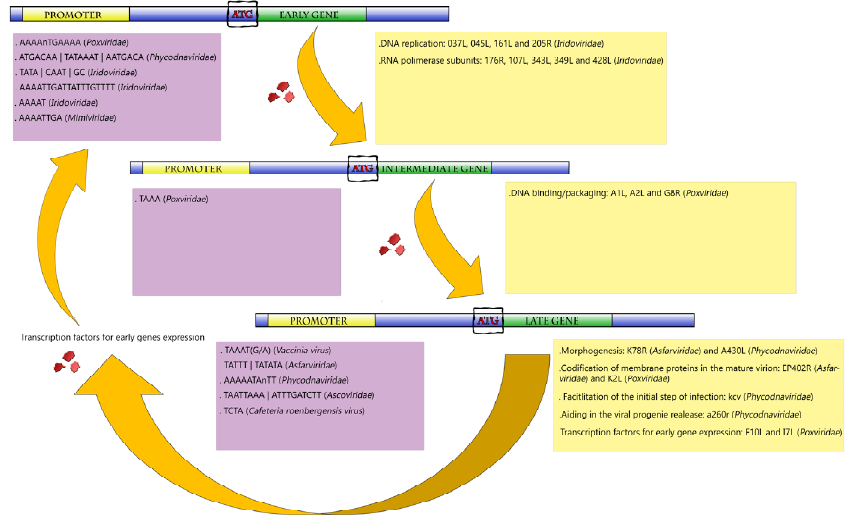
Figure 2. Representative scheme of the temporal gene expression in NCLDVs. During initial times of infection, the expression of genes related to the metabolism of nucleic acids is primarily activated (early and intermediate genes). After DNA replication, the activation of late genes is initiated. Those genes are involved in the production of viral structural proteins, in transcription factors used for early gene expression and also in proteins that facilitate the initial step of infection of the viral progeny in the next round of multiplication. Purple boxes represent the promoters described for giant viruses according to each gene category (early, intermediate and late genes). Yellow boxes exemplify the biological functions involved in each category, with some genes represented inside the parentheses.